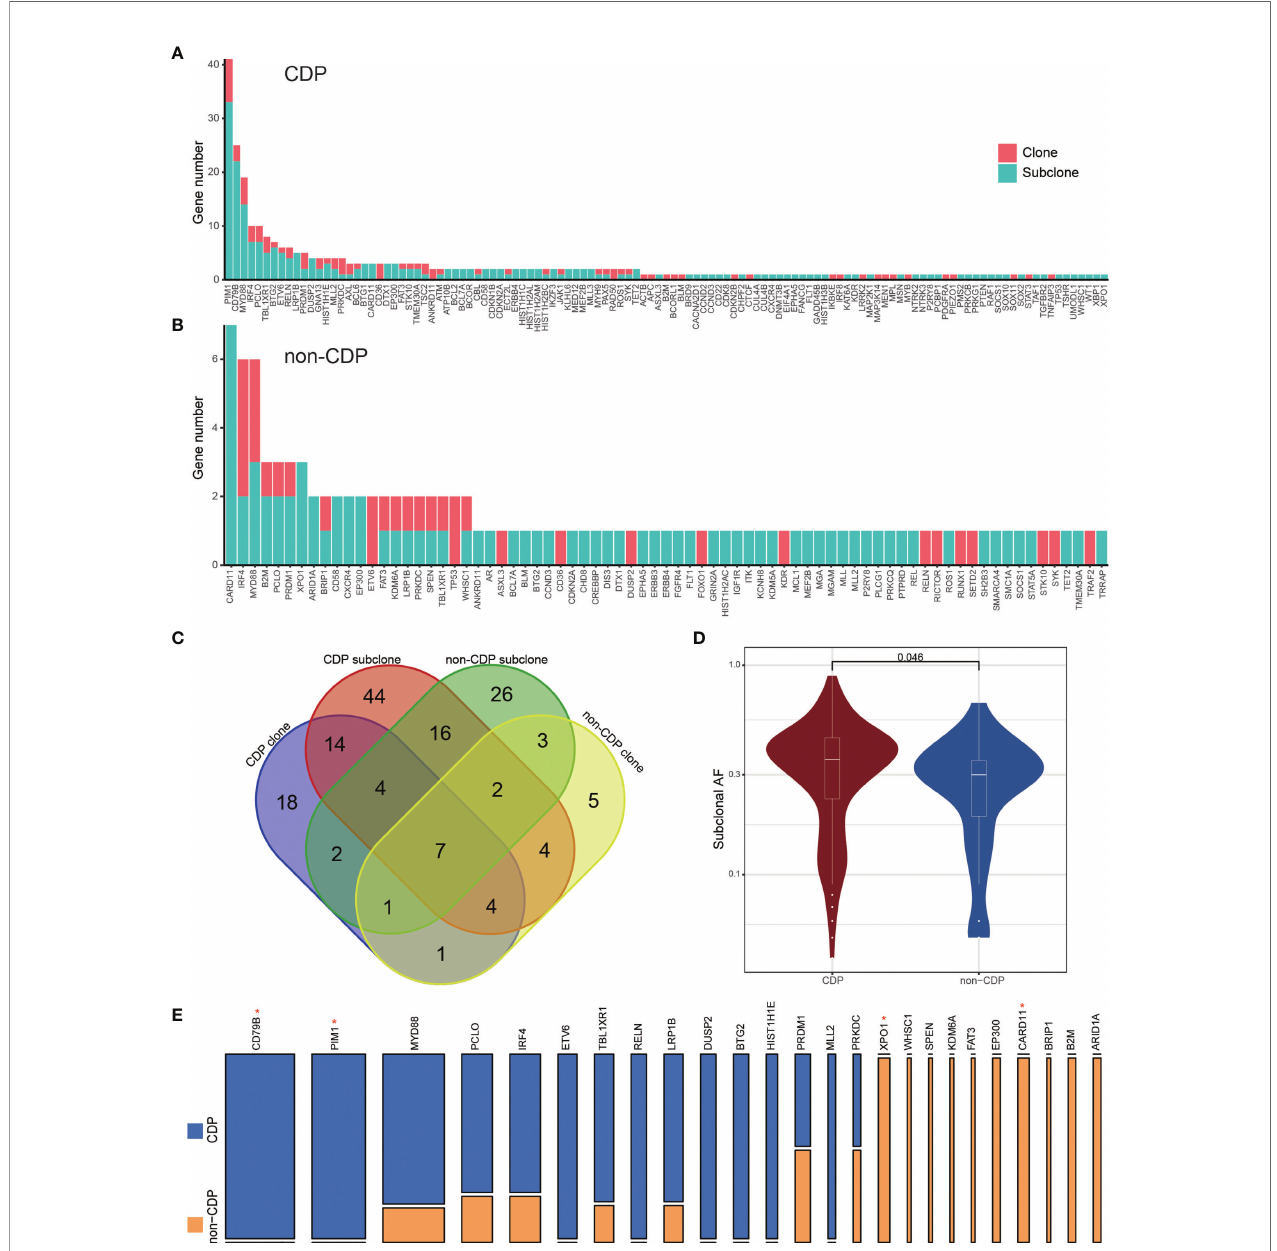
FIGURE 4 | PyClone analysis to CDP and non-CDP groups. The clone and subclonal distribution of mutant genes in the CDP group (A) and non-CDP group (B) . (C) The Venn diagram shows the shared genes status between groups. (D) shows the signi fi cant difference of allele frequencies in high-frequency subcloned mutant genes between the high CDP and non-CDP groups. (E) speci fi cally displays the proportion of high-frequency subcloned mutant genes between the CDP group and non-CDP group. The width of the column represents the number of patients carrying the mutant gene, and the height represents the mutant gene proportion of the two groups. * represents Fisher's exact test, P value <